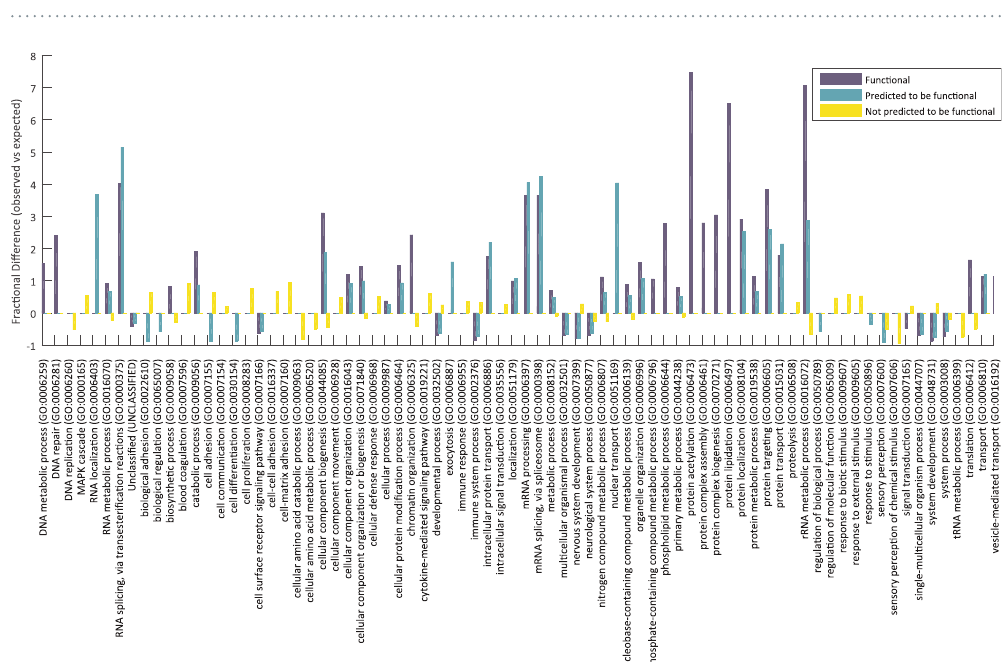
Figure 5. Comparison of fractional differences over GO terms of biological processes. In blue: hosting genes of functional introns, turquoise: hosting genes of introns predicted to be functional, yellow: hosting genes of introns not predicted to be